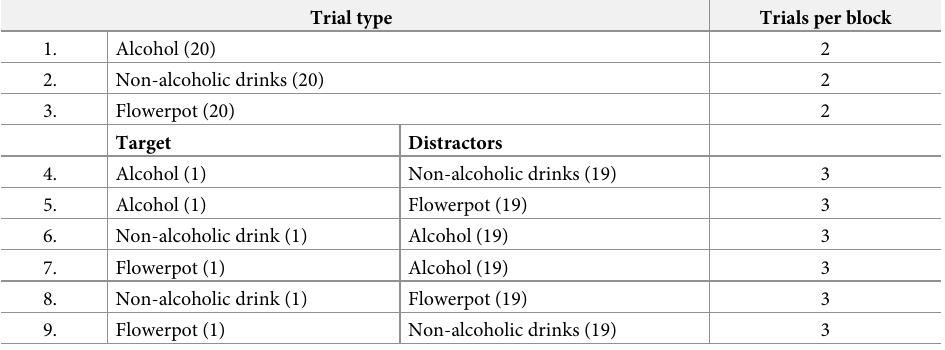
Table 1. Type and amount of trials in the Odd-One-Out Task (OOOT).